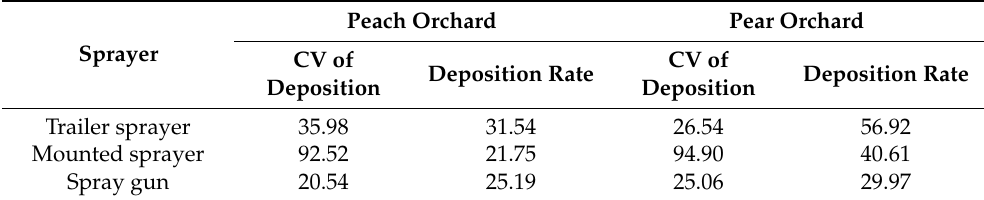
Table 7. Deposition rates (%) and coefficients of variation (%) of spray liquid in the peach and pear